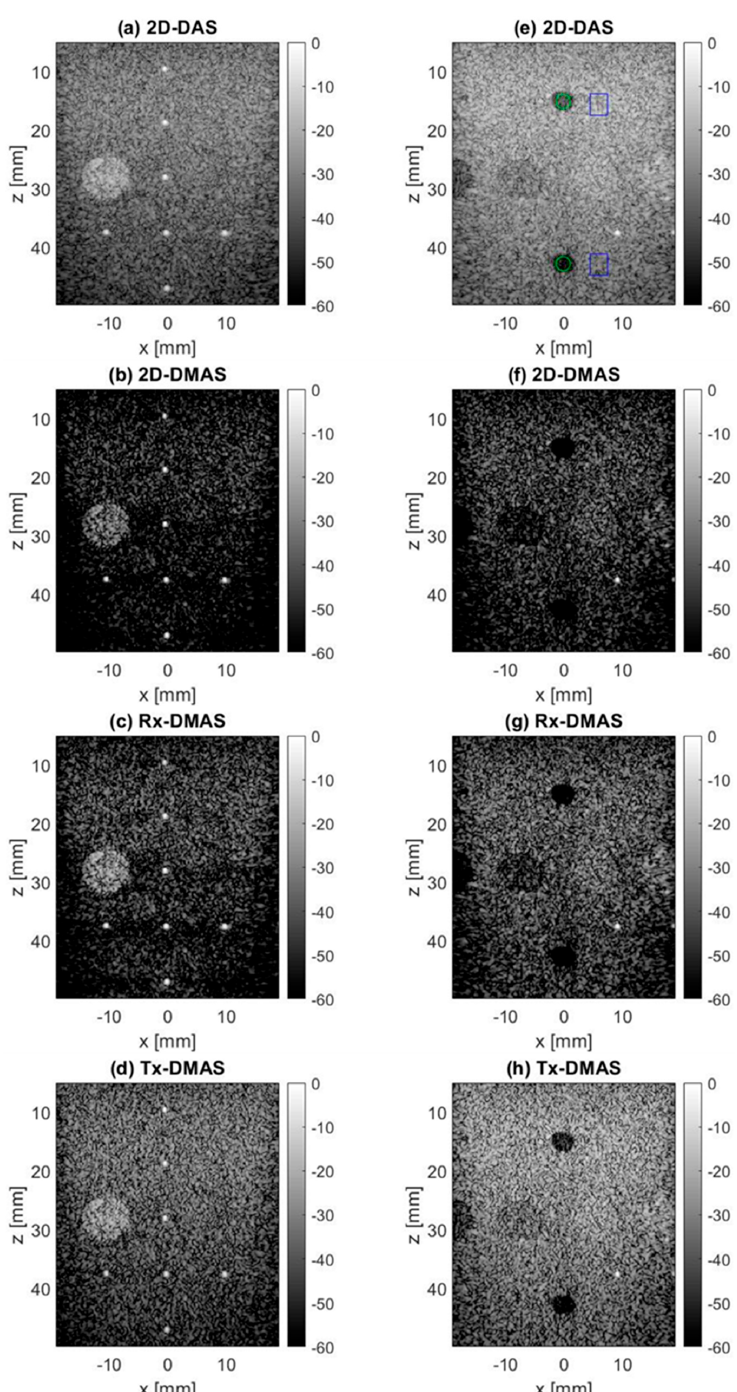
Figure 3. Experimental B-mode images of wire reflectors and various contrast cysts in speckle background for 2D-DAS, Rx-DMAS, Tx-DMAS, and 2D-DMAS beamforming: The p value in DMAS beamforming is fixed to 2.0.